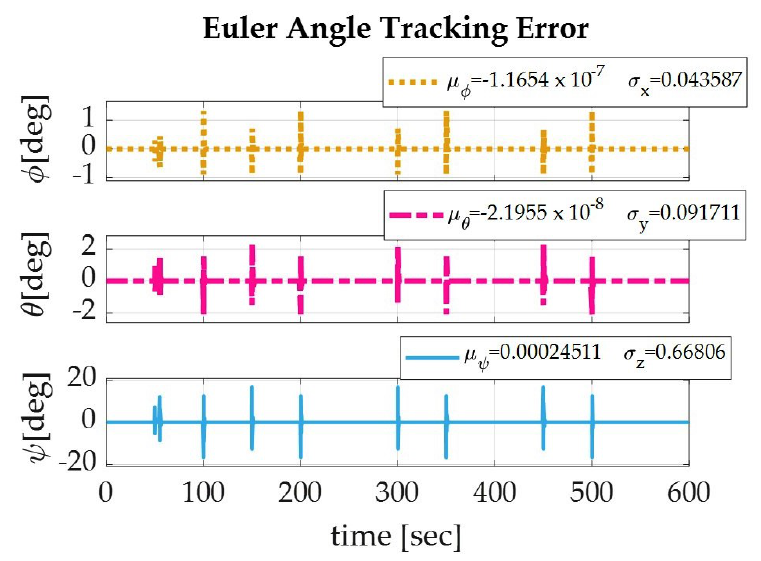
Figure 3. The Euler angle tracking errors for a spacecraft de-orbiting from LEO altitude (1000 km) using a sinusoidal autonomous trajectory for roll (yellow), pitch (pink), and yaw